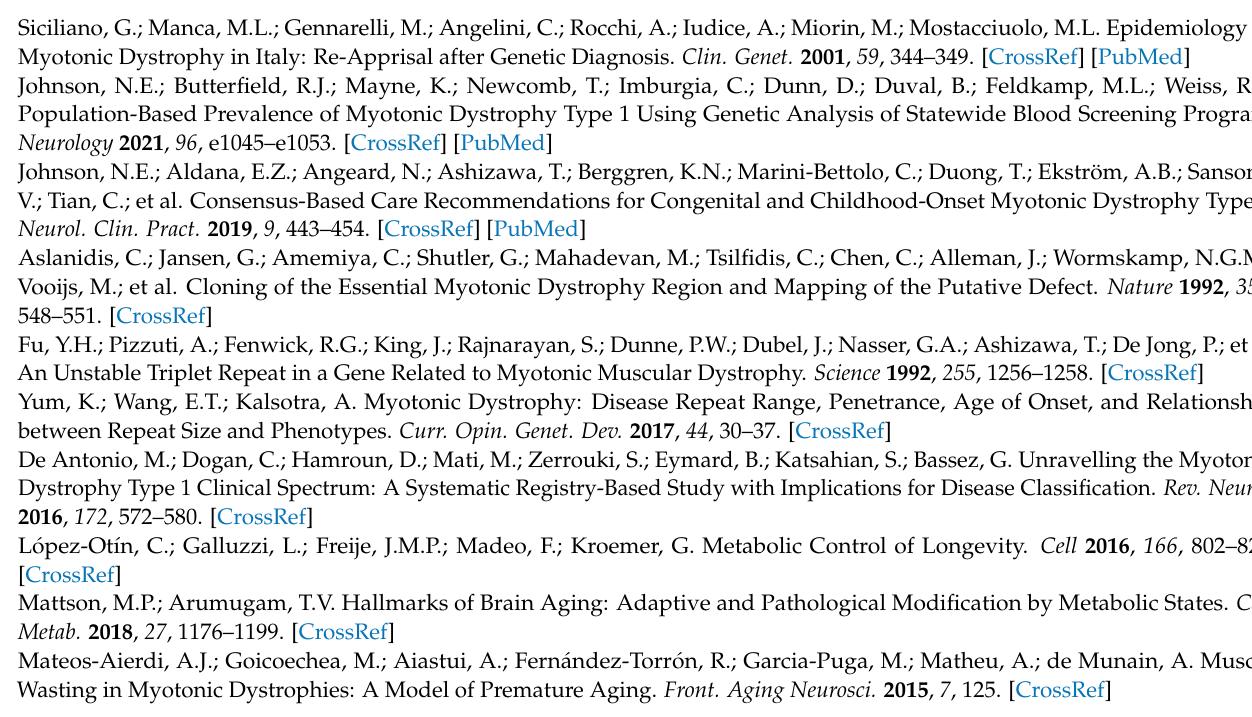
Table S2: Genes corresponding to the terms resulting from the DisGeNET search (disease: C3250443). Table S3: Gene terms common to DisGeNET and VOSviewer; Table S4: Additional genes/proteins cor- responding to the terms resulting from the closely related generic terms in VOSviewer; Table S5: Sub- cellular localization and molecular function of the list of 71 putative genes; Table S6: g:Profiler: GO: Bi- ological Process (BP); Table S7: g:Profiler: REAC signaling pathways; Table S8: VOSviewer occur- rences Score; Figure S1: Network map of occurrence distribution of the similar genes found both in Scopus and DisGeNET; Figure S2: PPI network comprising the 44